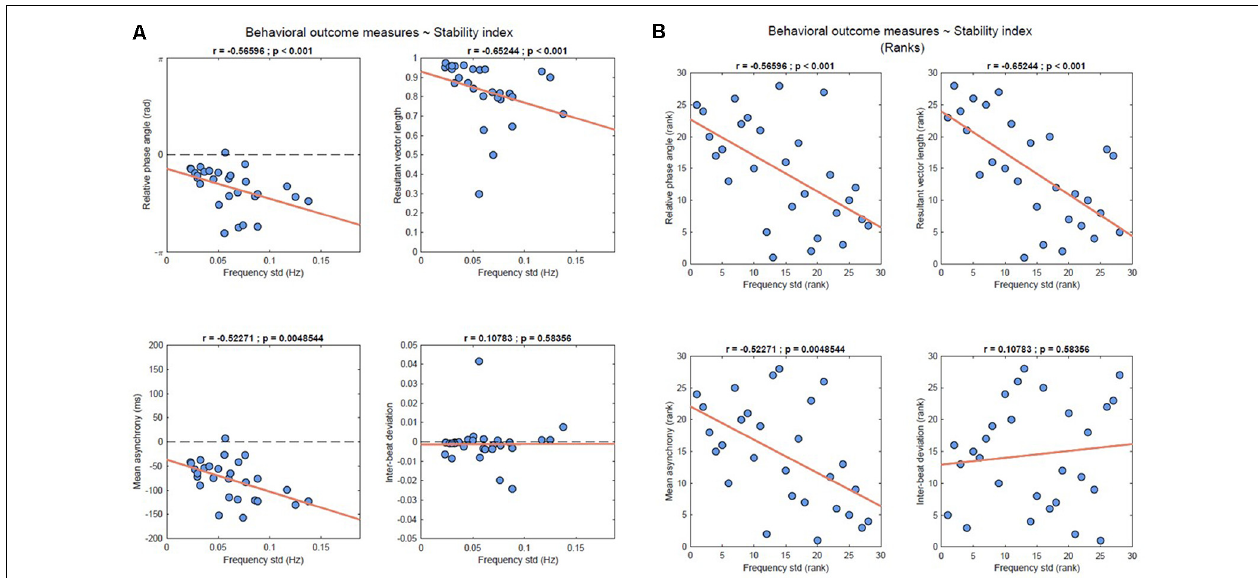
FIGURE 4 | (A) Results of the Spearman’s correlation analysis between the behavioral outcome measures and stability index of all study participants. Data are represented on the original scale. (B) Correlations between the ranks for the behavioral outcome measures and stability index of all study